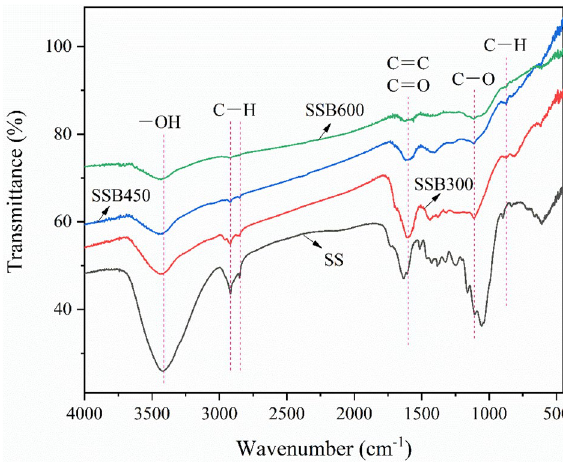
Figure 2. Infrared spectra of sorghum straw and its biochar.